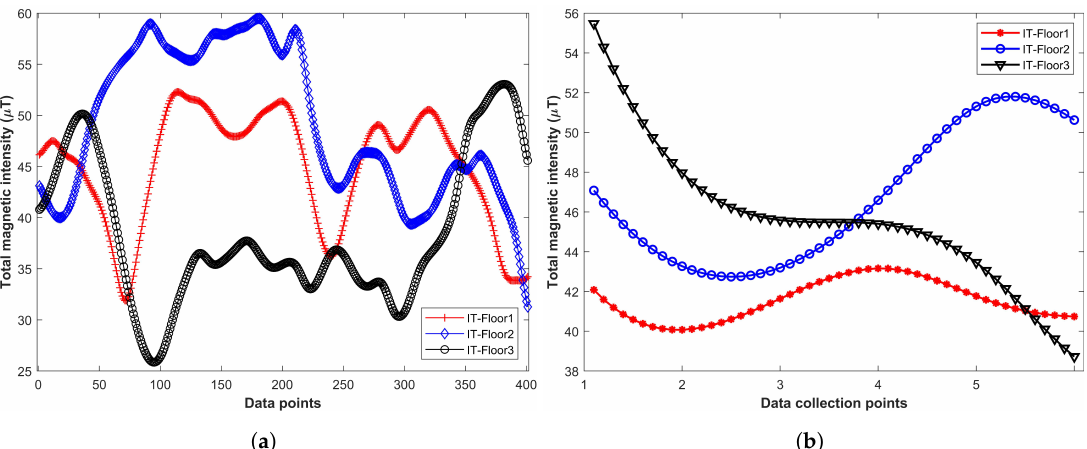
Figure 2. Total magnetic intensity, and its variation on same points of different floors. ( a ) Total magnetic intensity on different floors of IT building using S8, ( b ) Magnetic variation on same points of different floors using S8.